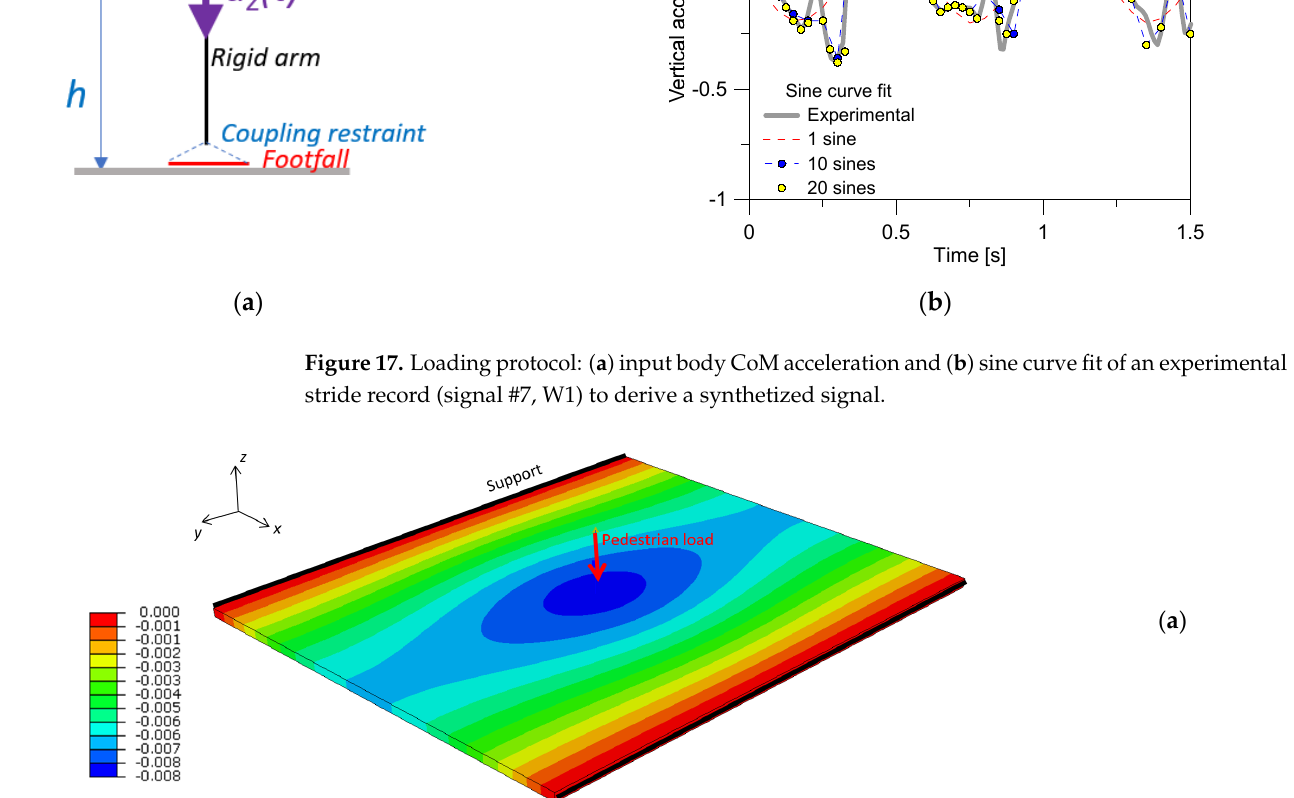
Figure 17. Loading protocol: ( a ) input body CoM acceleration and ( b ) sine curve fit of an experi- mental stride record (signal #7, W1) to derive a synthetized signal.